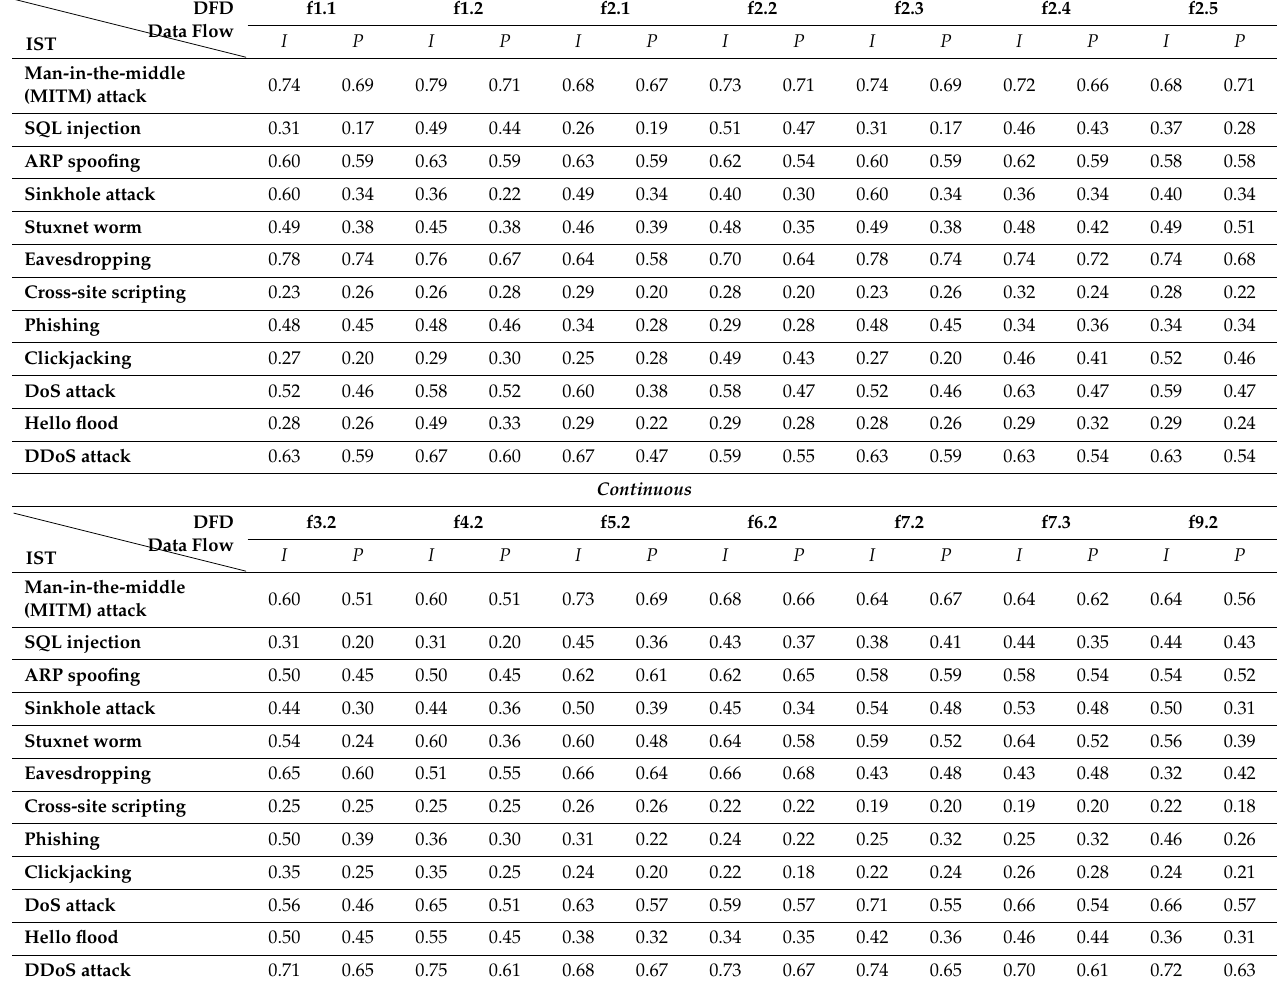
Table 3. The IST evaluation scores for DFD Data Flow of the ELB